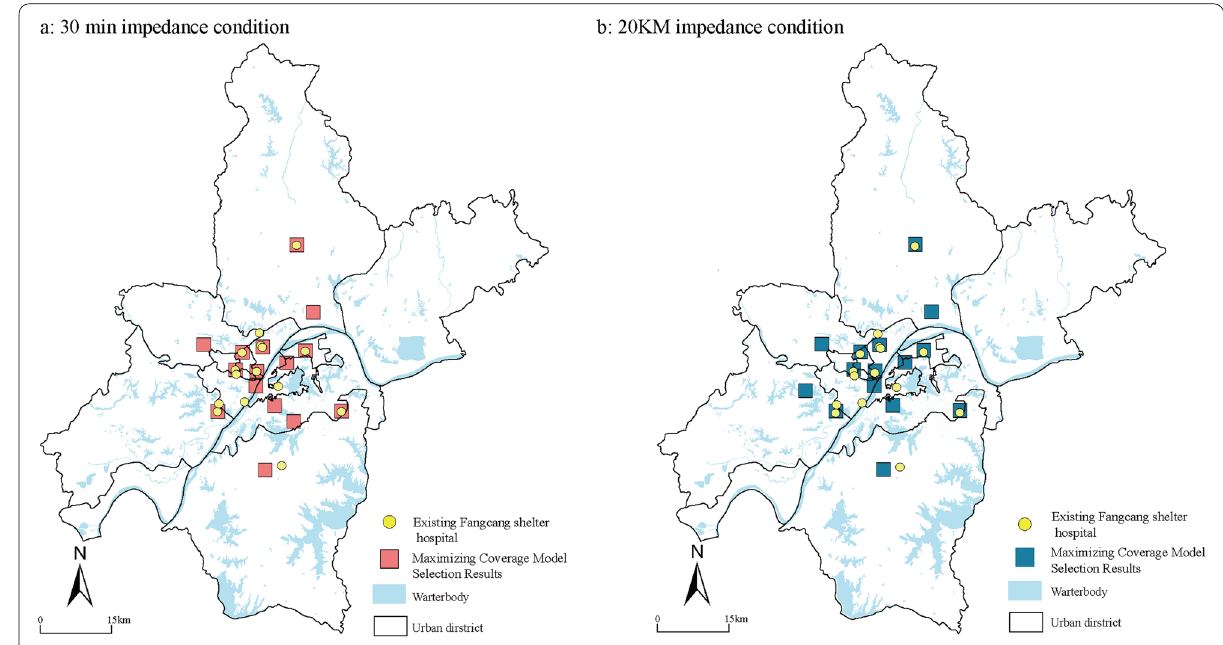
Fig. 9 Comparison between the optimization results of the maximum coverage model and the actual distribution of mobile cabin